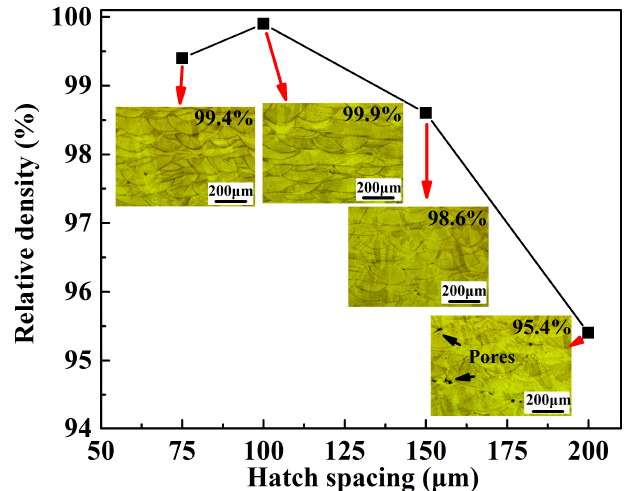
Figure 11. Effect of hatch spacing on the densification rate and cross-sectional microstructure of the SLM-processed 316L SS samples.